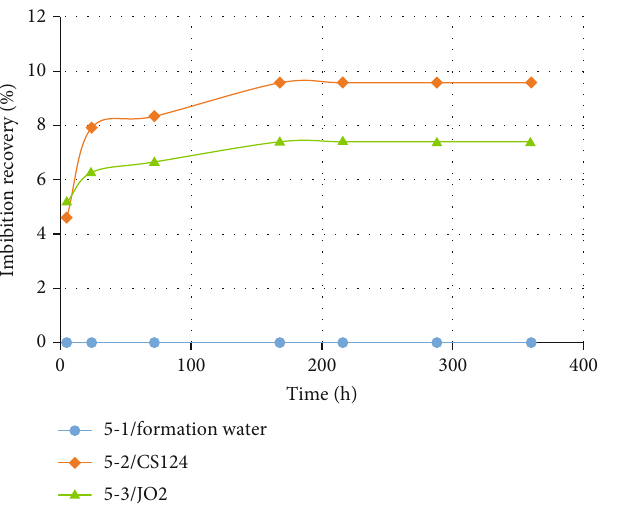
Figure 7: Oil-wet core imbibition recovery.